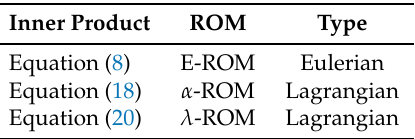
Table 1. The new Lagrangian reduced order models (ROMs) ( α -ROM and λ -ROM), the standard Eulerian ROM (E-ROM), and the inner products used to construct their bases.